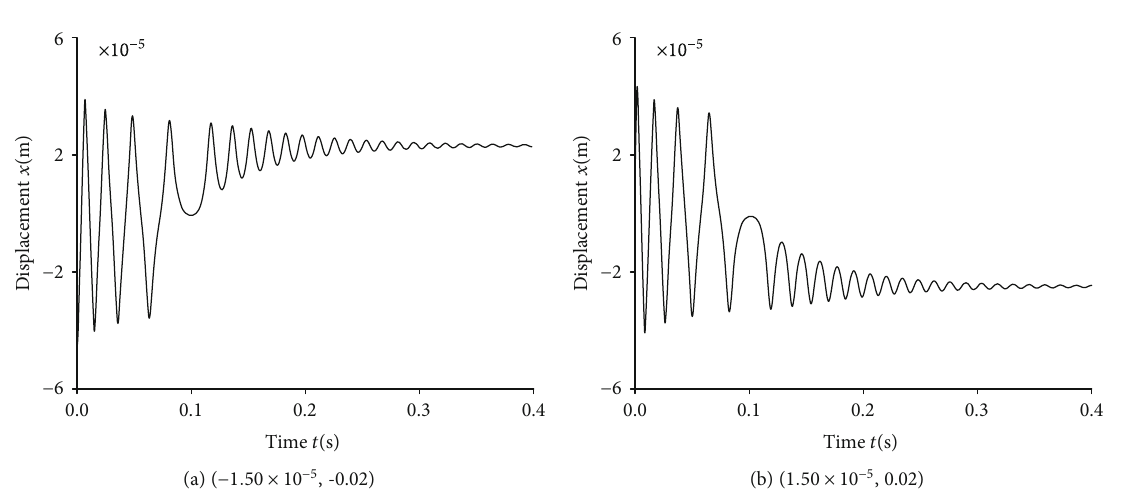
= 6 : 0 × 10 − 5 m , l = 0 : 5 × 10 − 5 m . 0